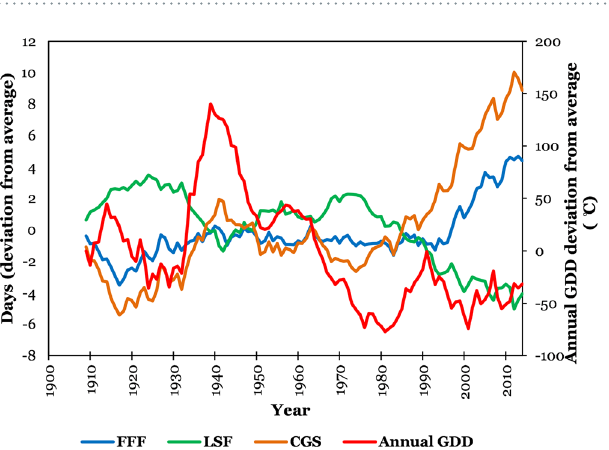
Figure 2. Spatial distribution of long-term average accumulated growing degree days (AGDD) for different months of the year. We created the maps using ESRI ArcMap 10.4.1 software http://desktop.arcgis.com/en/ arcmap/.